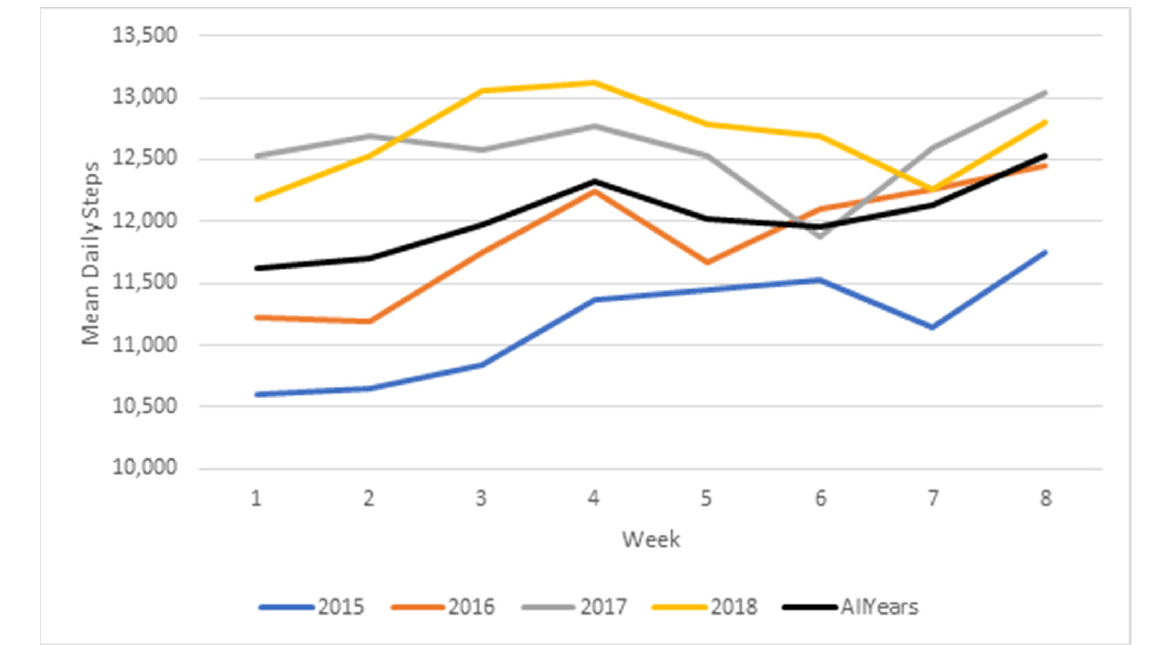
Figure 1. Change in step count over 8 weeks of Step Count Challenge by year and all years. When age and gender were added to model (Table 3) there were no consistent 3-way or 2-way effects. There was a consistent effect for gender, with women recording fewer steps than men ( p < 0.05, mean difference 1020.1 steps). There were inconsistent age effects. In three of the four years there was no effect for age, but in 2017 older participants ( ≥ 45 years) did more